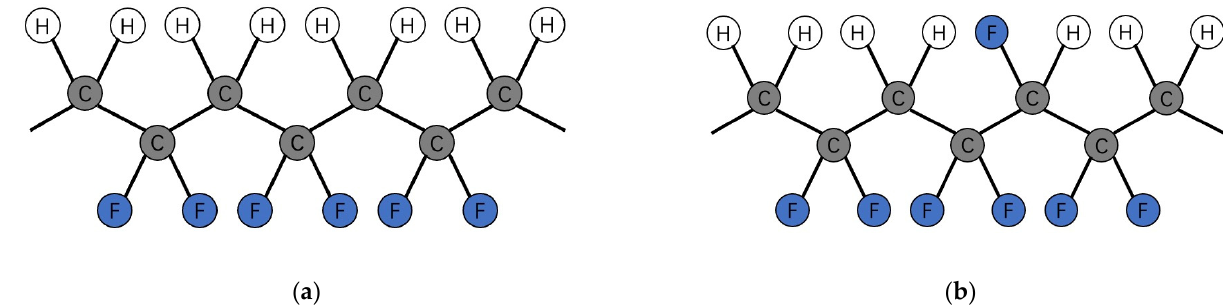
Figure 1. ( a ) Molecular conformation and crystal structures β -phases of PVDF [7]; ( b ) Schematic drawing of VDF-TrFE copolymer molecule in β phase (all-trans) conformation (right image) [8] .